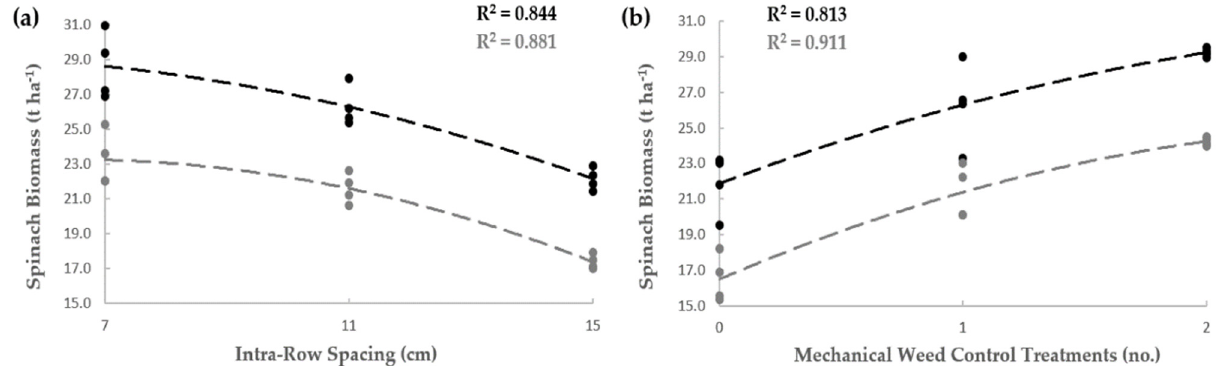
Figure 3. ( a ) Black: the relationship between total spinach biomass (t ha − 1 ) and intra-row spacing (cm). Grey: the relationship between commercial spinach biomass (t ha − 1 ) and intra-row spacing (cm). ( b ) Black: the relationship between total spinach biomass (t ha − 1 ) and the number of mechanical weed control treatments. Grey: the relationship between commercial spinach biomass (t ha − 1 ) and the number of mechanical weed control treatments.